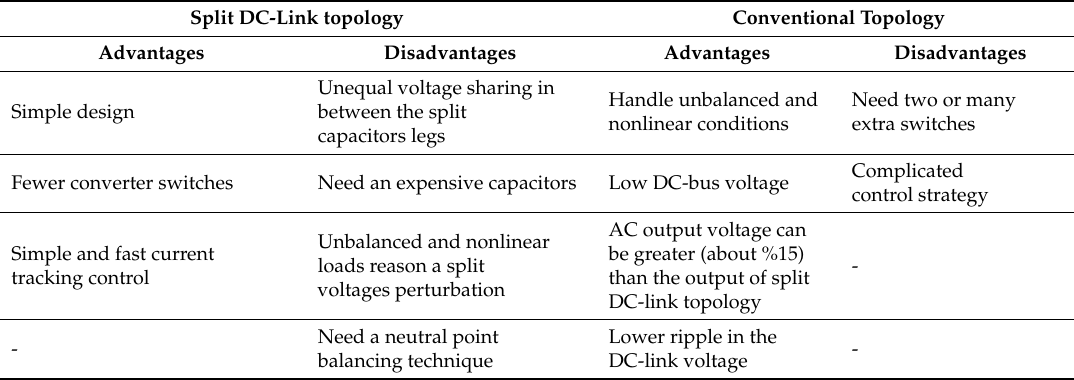
Table 8. Performance comparison of split DC-leg APF with conventional APF